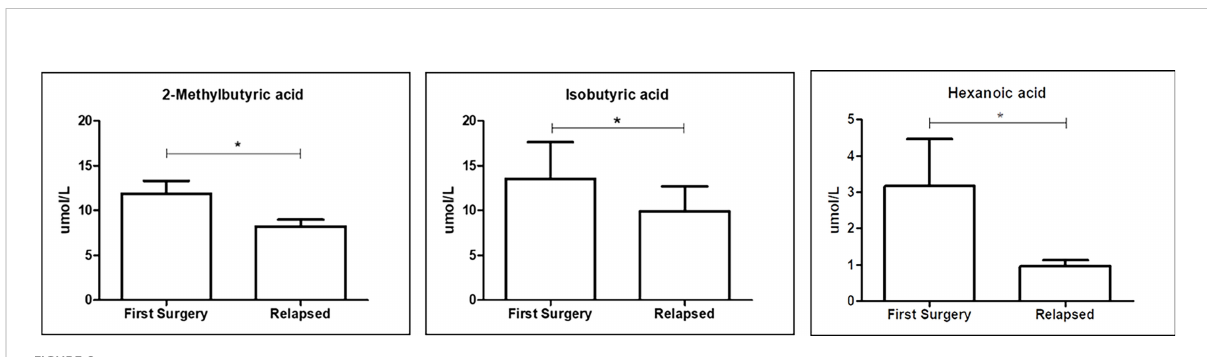
FIGURE 8 Box plot reporting the statistically signi fi cantly different FFAs between the fi rst surgery and relapse patients. Analyses were assessed using the Mann – Whitney test, and p – values less than 0.05 were considered statistically signi fi cant. The asterisks (*) represent p – values: *p <